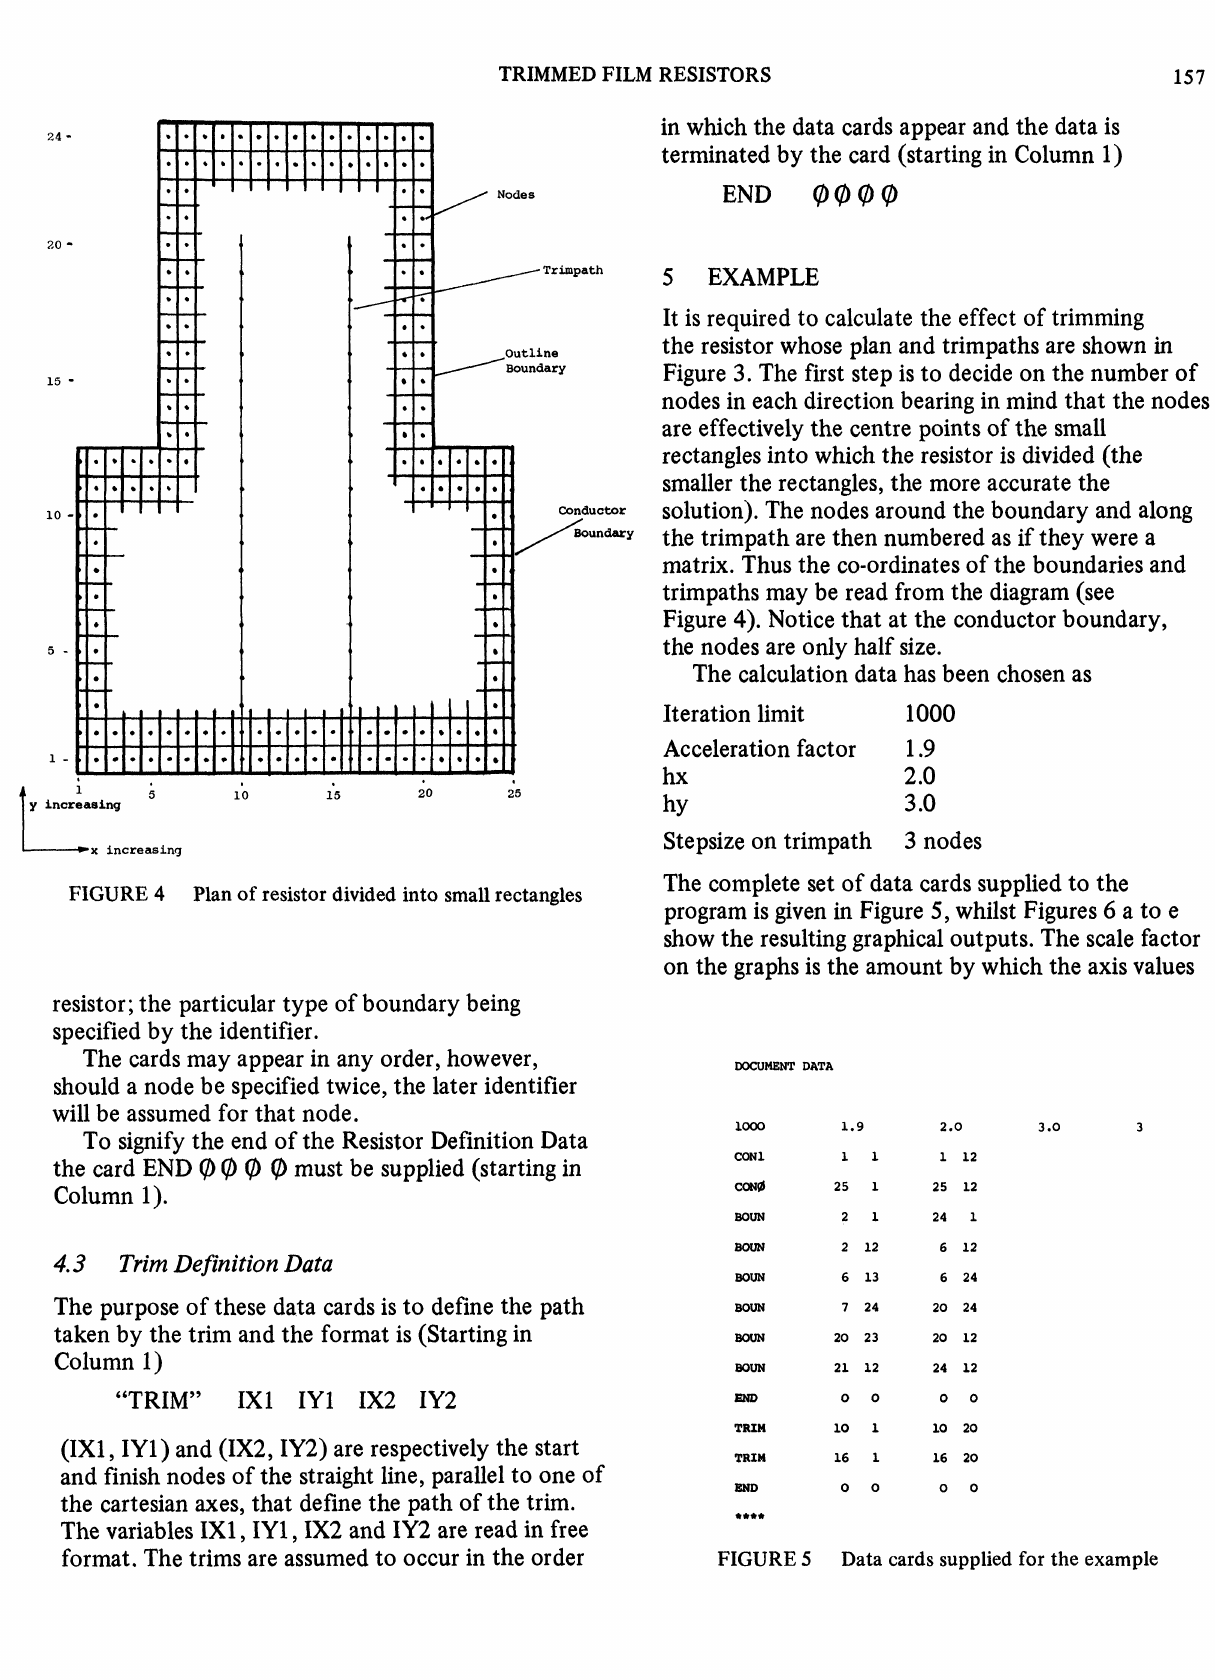
Data cards supplied for the